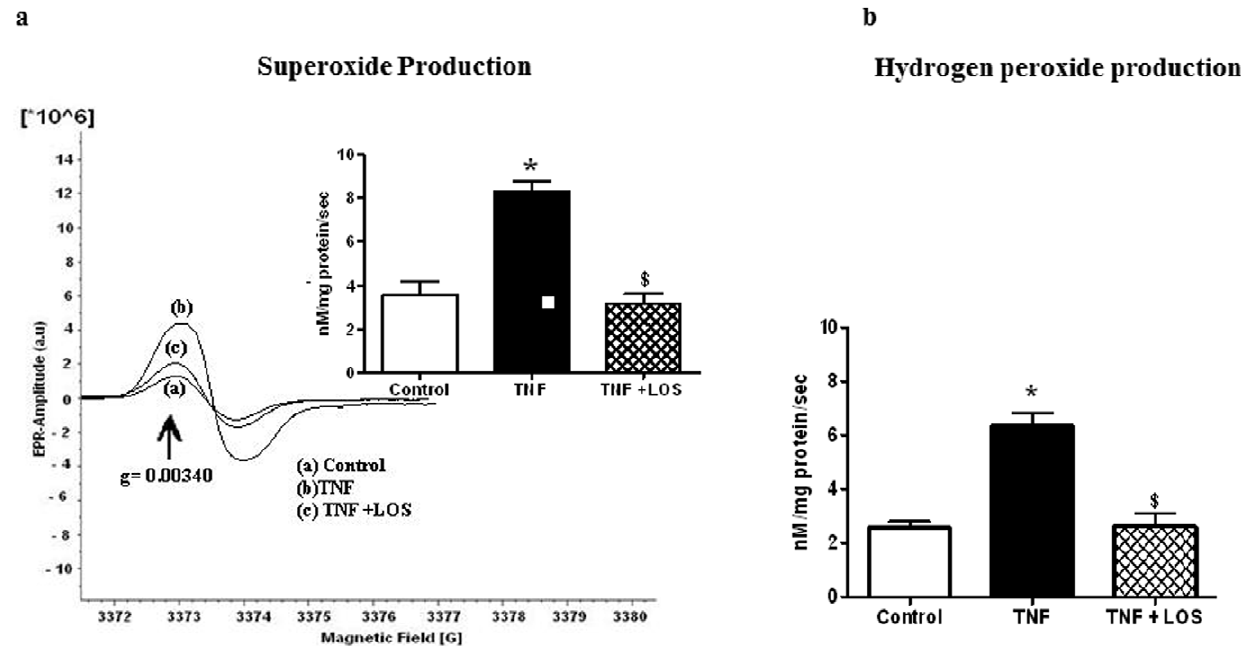
Figure 4. Effect of TNF on superoxide production rates and hydrogen peroxide production rates in isolated heart mitochondria from each experimental group as measured by EPR spectroscopy (a&b). Administration of TNF to rats resulted in significant increases in superoxide and hydrogen peroxide production rates. Losartan attenuated these changes. * p , 0.05 vs. control; $ p , 0.05 vs.TNF.